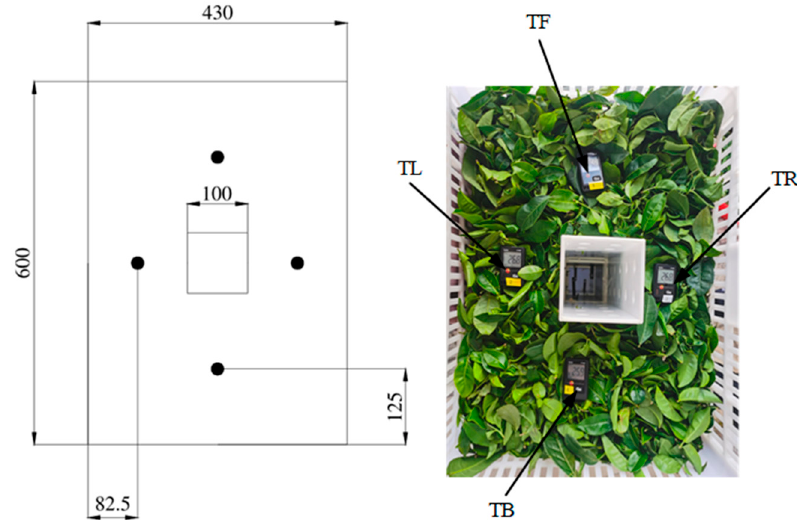
Figure 4. The arrangement of temperature sensors in the basket.